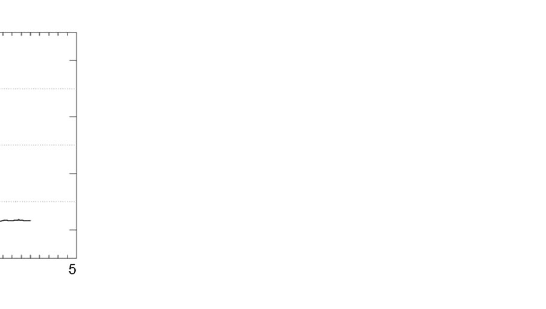
Figure 10. XRR data from B 4 C-coated test mirror after cleaning with pure O 2 plasma cleaning. (red solid lines: experimental XRR data; black solid lines: IMD